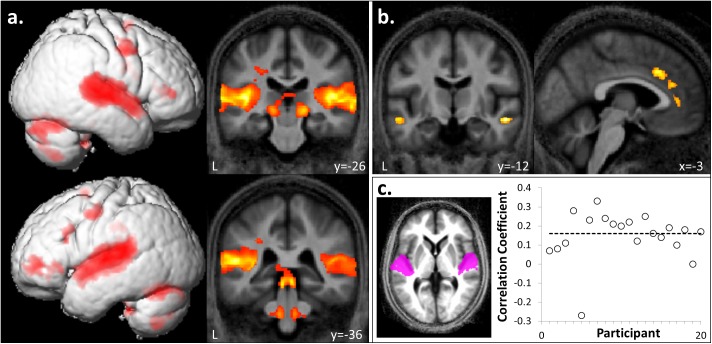
Whole brain responses to auditory stimulation and correlation with intracortical myelination. (a) A bilateral auditory brain network, including superior colliculi, lateral geniculate nuclei, superior temporal, and inferior frontal gyri was activated during passive listening to sound compared to silence ([FI + FA + UI + UA] > silence). (b) In contrast, anterior cingulate, bilateral anterior superior temporal sulci and cuneus showed relatively more activation during silence ([FI + FA + UI + UA] < silence). Significant clusters (cluster pFWE< 0.05, voxel punc< 0.001) are displayed on the group mean MT map normalized to a group template brain image in Montreal Neurological Institute (MNI) standard space. (c) Plot of correlation coefficients between magnetization transfer values (a metric of intracortical myelin integrity) and BOLD response (t-score) in Heschl’s gyrus (HG) for the auditory stimulation contrast collapsed across hemispheres, for individual participants (n = 20). The mean corrected correlation coefficient is indicated by the horizontal line. Inset, HG regions of interest displayed on the group mean MT map normalized to a group template brain image in MNI space.